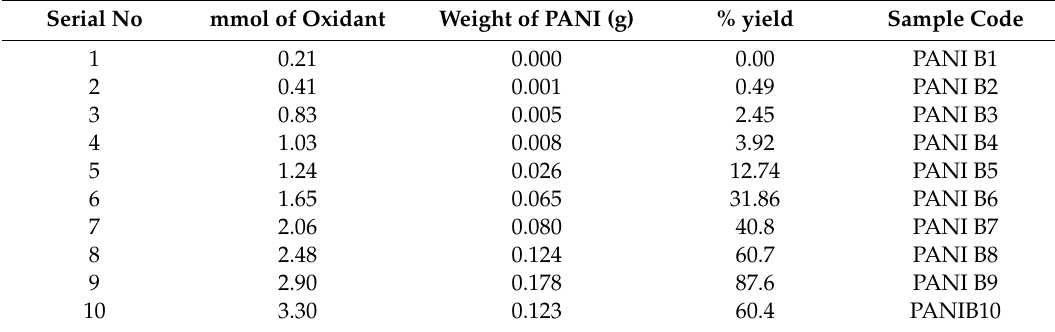
Table 3. E ff ect of amount of oxidant (Benzoyl peroxide) on percent yield PANI.